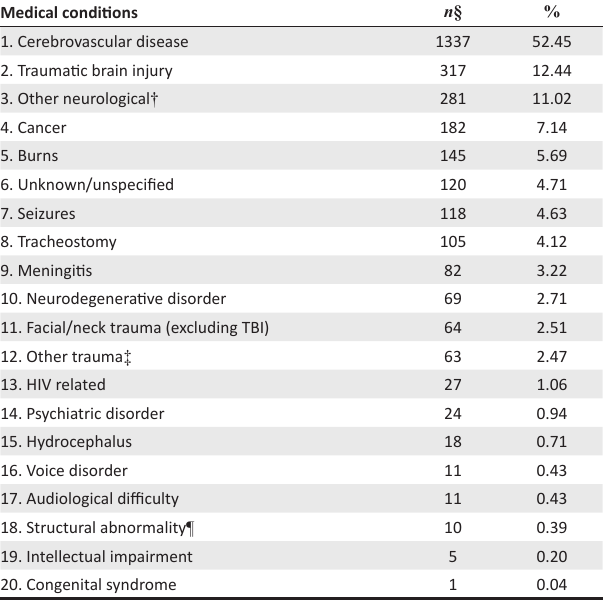
TABLE 2: Medical conditions ( n = 2549).